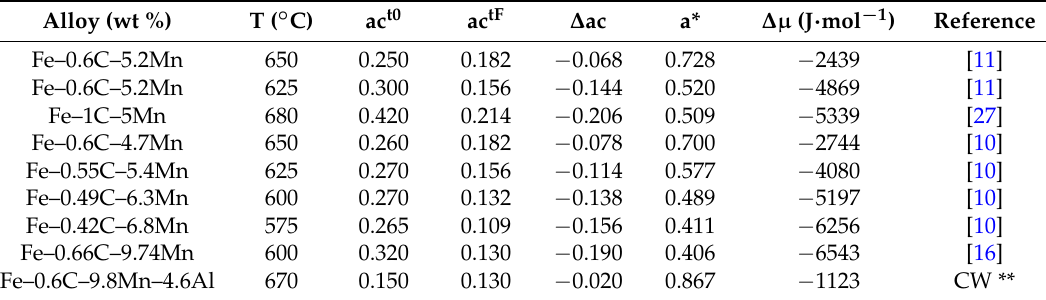
Table 2. Values for the activity of carbon in the austenite at the beginning (ac t0 ) and at the end (ac tF ) of the divergent pearlite transformation for different system alloys and isothermal temperatures (T), all of which were transformed in the γ + α + θ three-phase field. ∆ ac and a* are the difference between ac tF and ac t0 , and the ratio between ac tF and ac t0 (ac tF /ac t0 ), respectively. T ( ◦ C) ac tF ∆ ac ∆ µ (J · mol − 1